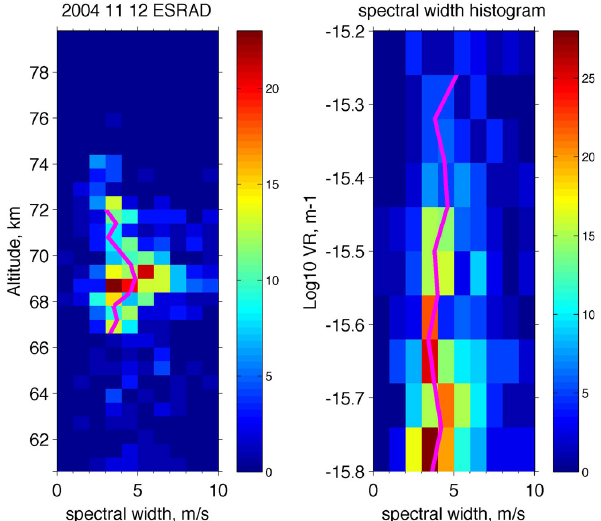
Fig. 8. Histograms of half-maximum half-width of power spec- tra at each altitude (left panel) and each value of logarithm of the ESRAD volume reflectivity (right panel) for PMWE measured on 12 November 2004. Colour indicates number of cases when half- maximum half-width has a value in the particular spectral width bin. The median HMHWs are indicated in